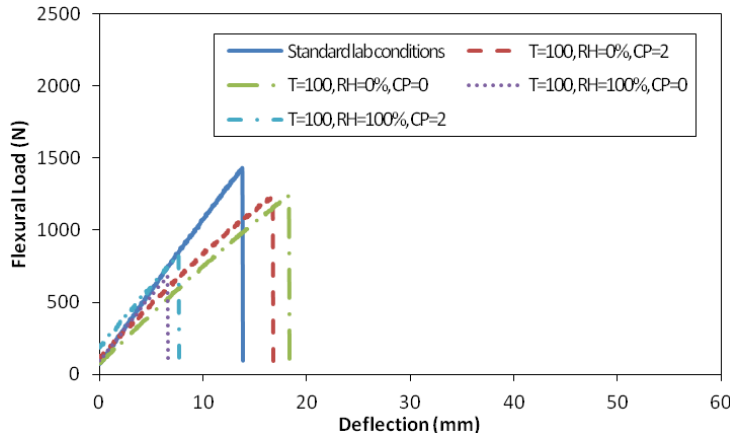
Figure 7. Flexural load-mid span deflection curves after 625 cycles under the conditions of 100 °C, humidity (0% and 100%), cycle period (Cp = 0 and 2).